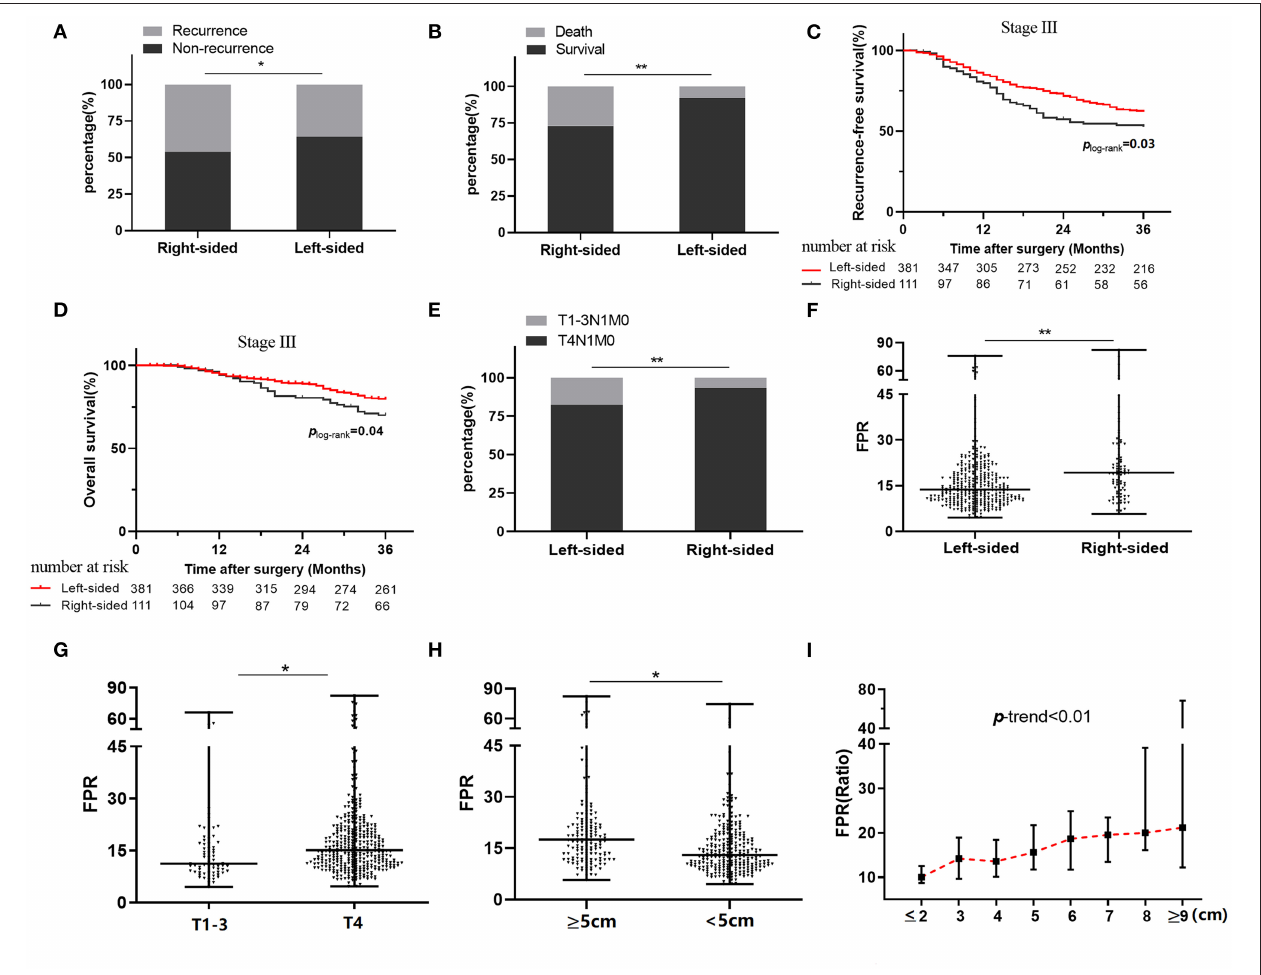
FIGURE 2 | Relationship between clinical outcome, tumor sidedness, and preoperative FPR in stage III colorectal cancer patients. (A) Recurrence status in stage III patients stratified by tumor sidedness. (B) Death status in stage III patients stratified by tumor sidedness. (C) Kaplan–Meier curves for RFS in stage III patients with right-sided and left-sided cancer. (D) Kaplan–Meier curves for OS in stage III patients with right-sided and left-sided cancer. (E) Frequency distribution of T4 stage in left-sided and right-sided cancer. (F) Preoperative FPR in left-sided and right-sided cancer. (G) Preoperative FPR in T1–3 and T4 subgroup. (H) Preoperative FPR in subgroups with large ( ≥ 5cm) or small ( < 5cm) cancer size. (I) The change of median preoperative FPR in different cancer sizes. FPR, Fib to pre-Alb ratio; * ≤ 0.05. ** ≤